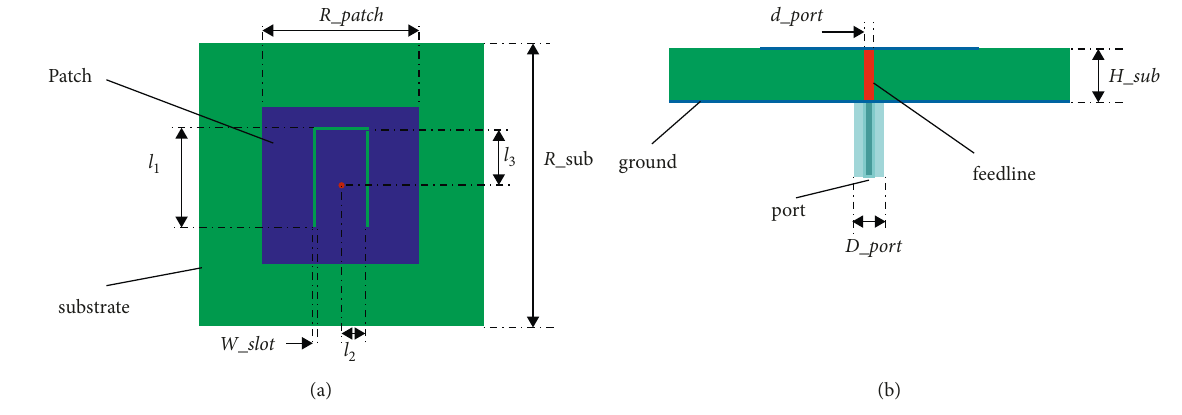
Figure 4: (a) The top view and (b) the front view of the patch antenna. Table 1: The parameters of the patch antenna.